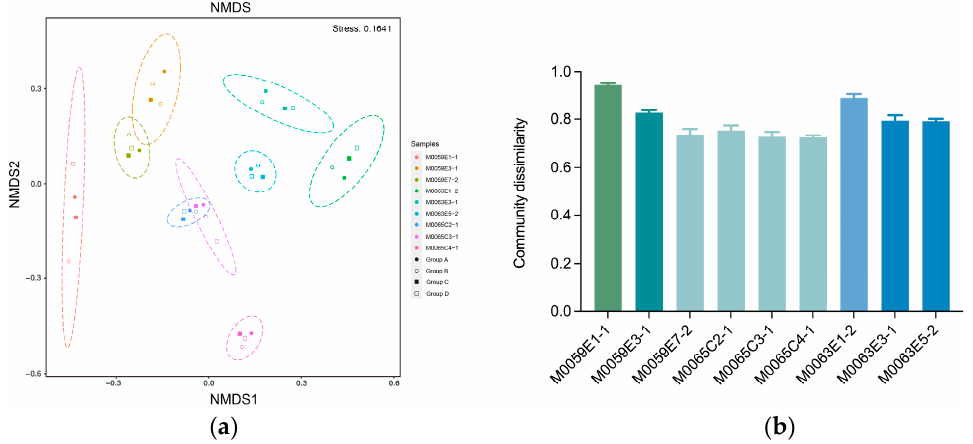
Figure 4. ( a ) A NMDS analysis of a Bray − Curtis dissimilarity matrix. The 95% confidence ellipse was added for each sample. ( b ) Dissimilarities among different groups of grinding beads from the same sample. The line in data plots indicate median value with SD ; different colors indicate that there is a significant difference between the samples ( p < 0.05).